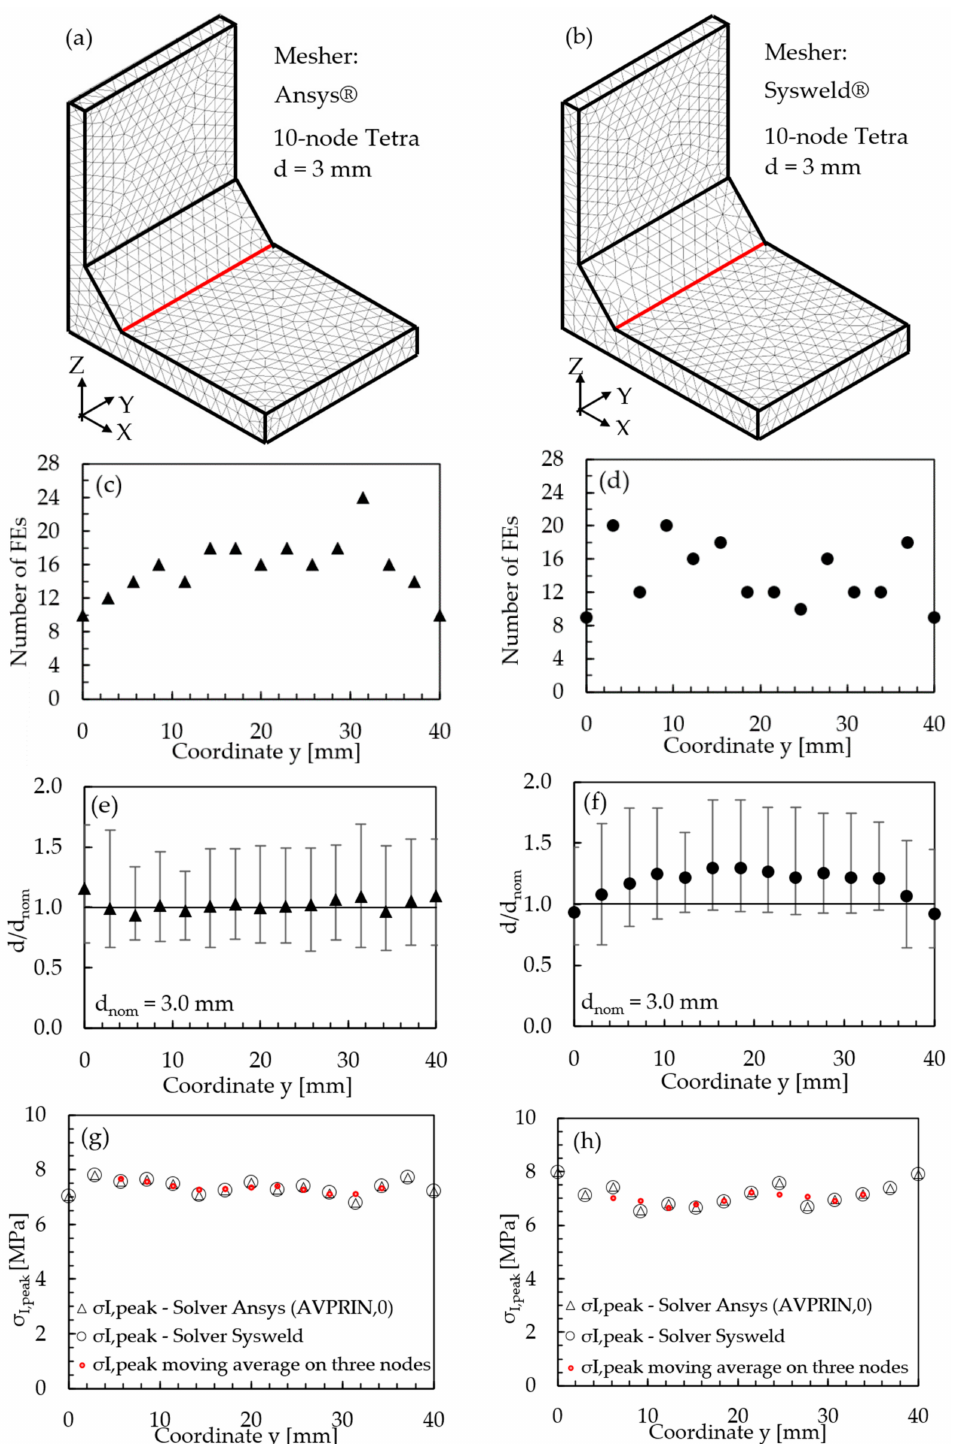
Figure 3. FE models to apply the PSM to the welded joint of Figure 2. Free mesh pattern of 10-node tetra elements with nominal element size d = 3 mm and generated in ( a ) Ansys ® and ( b ) Sysweld ® code. ( c , d ) Number of finite elements that share each vertex node at the weld toe. ( e , f ) Normalized size of finite elements that share each vertex node at the weld toe. ( g , h ) Comparison of peak stress distributions calculated by Ansys ® and Sysweld ® along the weld toe line of the FE models reported in ( a , b ),